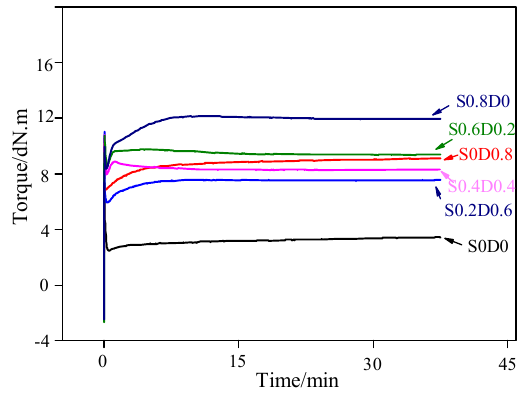
Figure 1. Cross-linking curves of PNB. Table 2. Cross-linking characteristics of PNB.